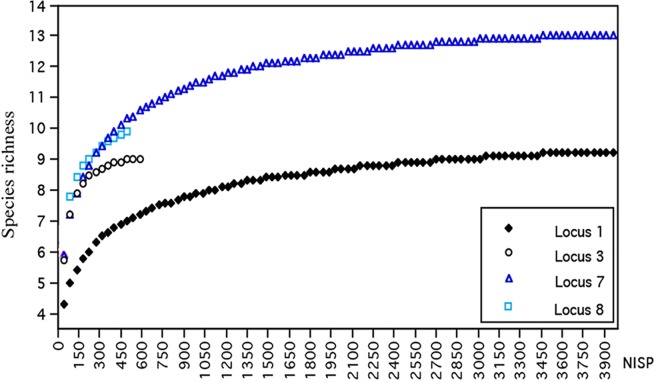
Rarefaction curves for species richness, as a function of NISP, according to the studied loci.